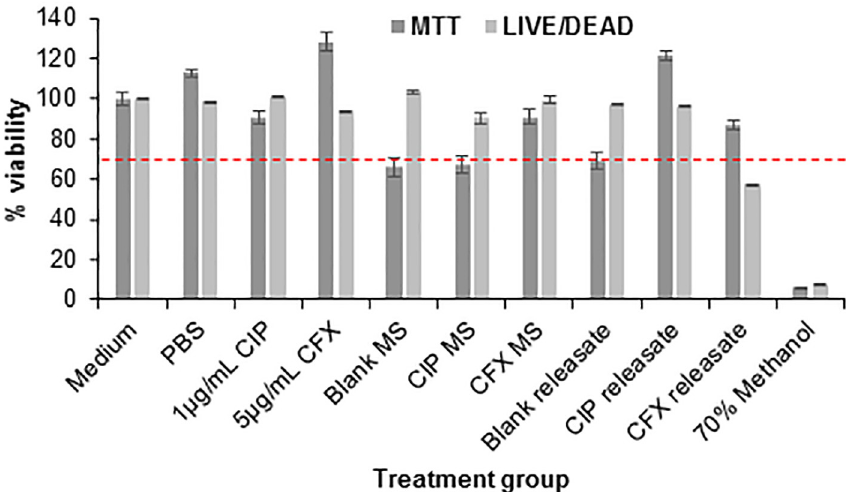
Fig 4. Cytotoxicity of antibiotics, microspheres, and releasates. Cell viability assays show acceptable levels of cytotoxicity due to application of blank and drug-loaded microspheres and microsphere releasates to human dermal keratinocytes for 24h. Error bars represent average ± standard error for n = 3 samples for all groups except Medium, PBS, Blank MS, and Blank releasate groups which have n = 6 samples. Red dashed line indicates 70% viability, the minimum recommended for medical devices [59–61].